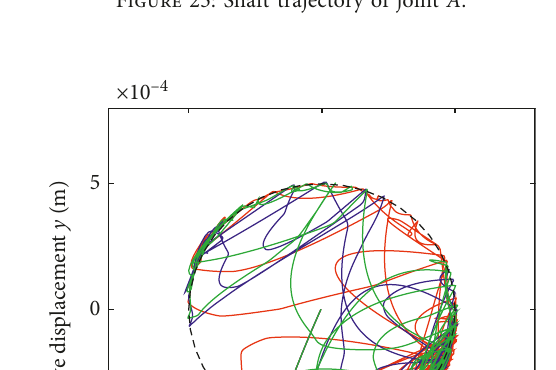
Figure 25: Shaft trajectory of joint A .